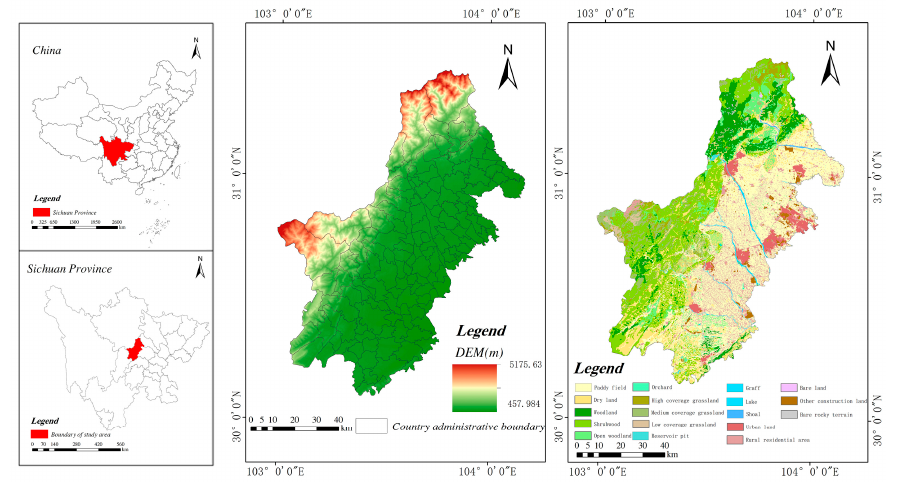
Figure 1. Location of the research